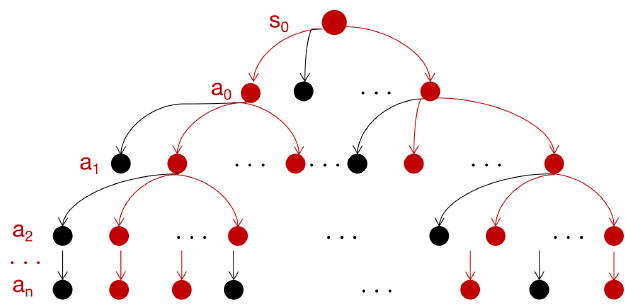
Figure 2. Scenario generating process can be described as a decision tree based on